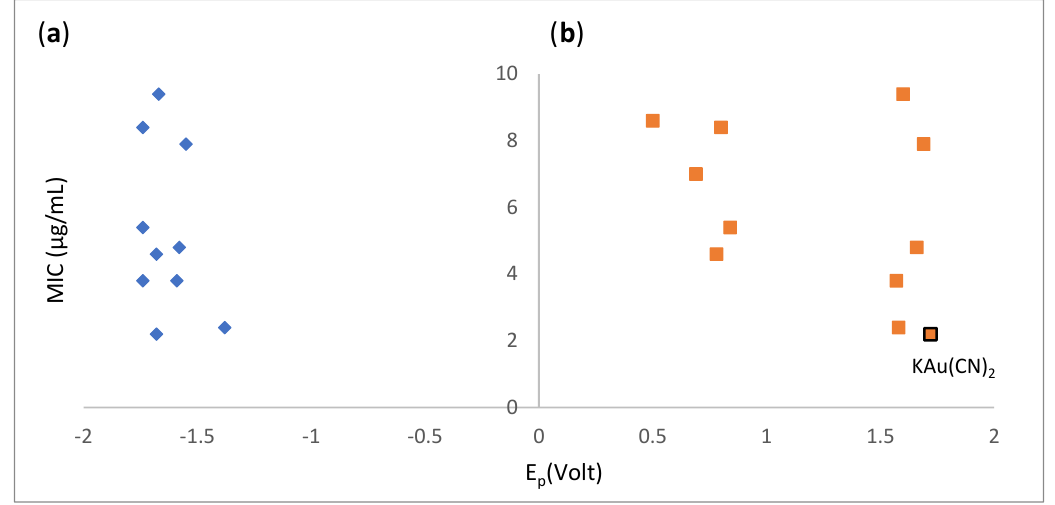
Figure 5. Relationship between the MIC values for B. contaminans and the redox potentials for the complexes. The anodic processes accommodate within two ranges of potentials either for P. aeruginosa or B. contaminans (Figures 4b and 5b). The complexes with just one ligand ( 1 , 2 , 11 , 13 ) tend to fit into the range of the lower potentials, while those with two ligands ( 5 , 7 , 10 ) fit the potential values that include the KAu(CN) 2 precursor. The electron releasing/withdrawing properties of the camphorimine ligands (L = OC 10 H 14 NY) may drive the redox and structure of the complexes, since electron donor ligands (Y = C 6 H 4 NH 2 , C 6 H 4 N; Z = m -C 6 H 4 , Scheme 1) tend to produce mono ligand-complexes that oxidize at the lower range of